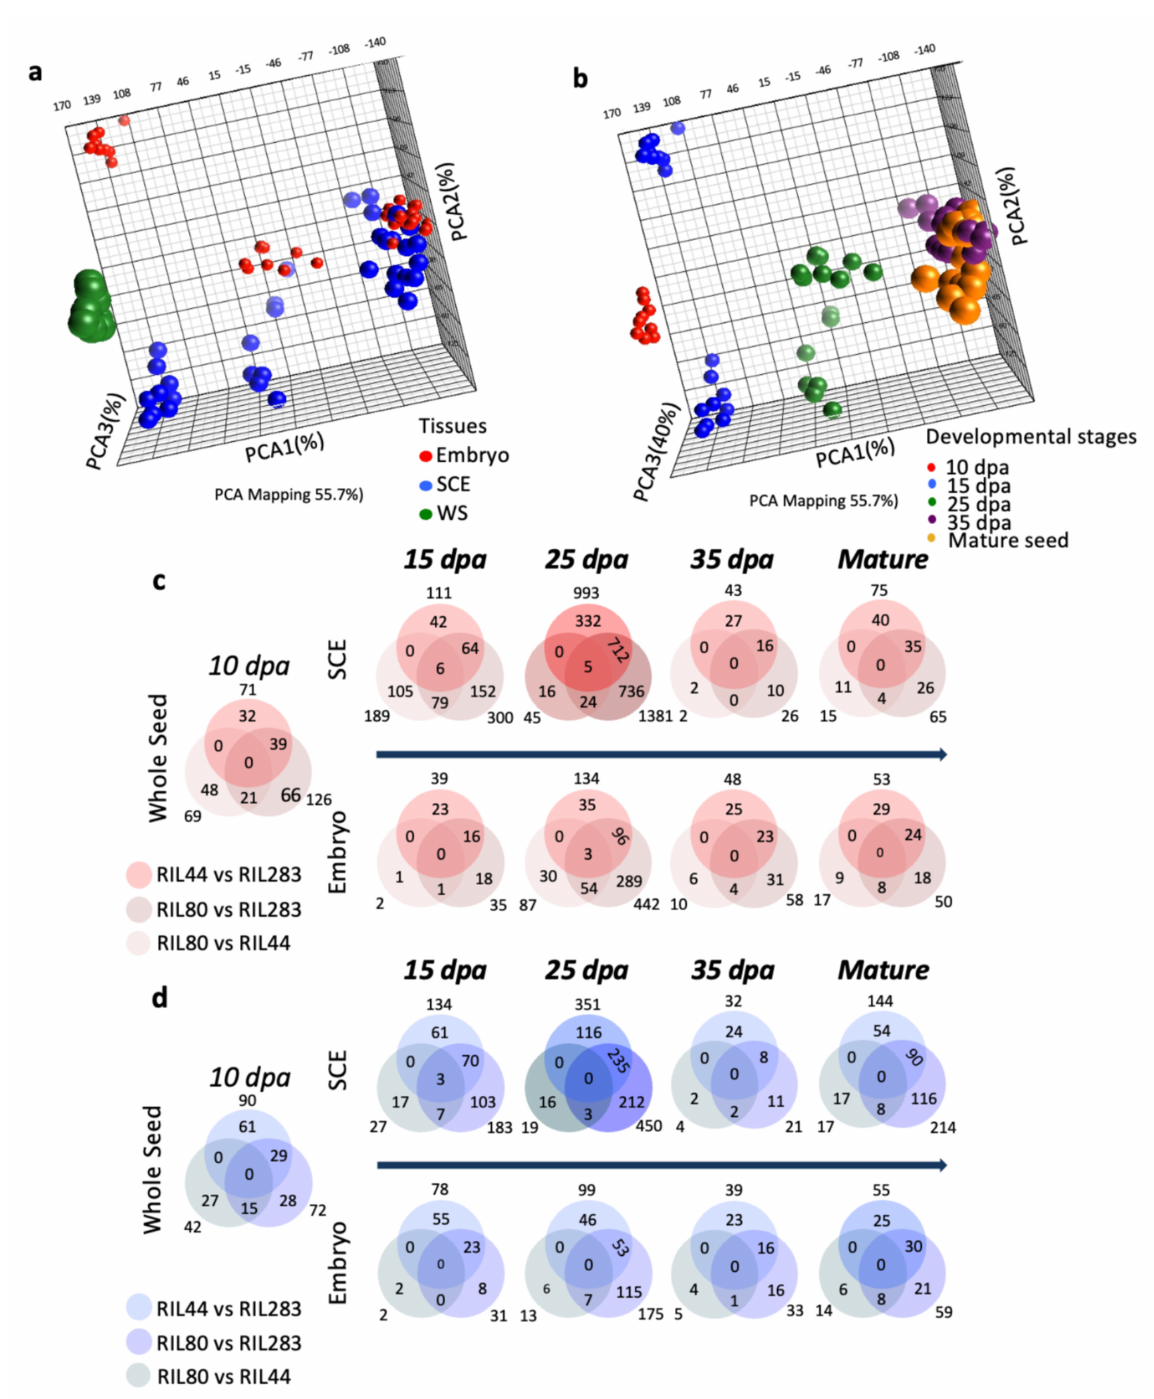
Figure 3. Transcriptomic analysis in flax RILs during seed development. ( a , b ) 3D-PCA scores plot of the dataset from the 81 Affymetrix oligo microarrays analysis performed on the three selected RILs. PCAs are labelled according to the specific tissues following the vertical component ( a ) and the developmental stages following the horizontal component ( b ). Various sizes were applied to each sample attribute for a better display of the results. ( c , d ) Pairwise comparisons analysis of the number of genes differentially expressed between the three selected RILs. Venn diagram show the number of unique and overlapping genes upregulated ( c ) or downregulated (d) between at least two RILs. A three-way ANOVA (Fold-change > 2 ( c ) or < − 2 ( d ), p -value adjusted with FDR < 0.05) was used for extraction and combination of the genes lists. Bold circles represent the most important lists of unique and overlapping differentially expressed